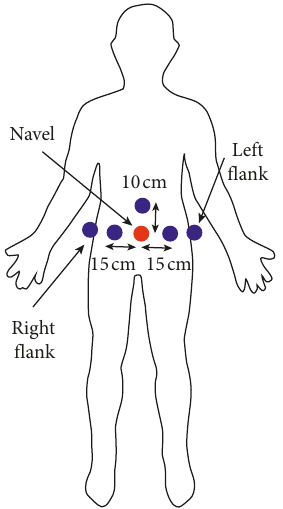
Figure 20: On-body positions of the reflector-backed antenna.